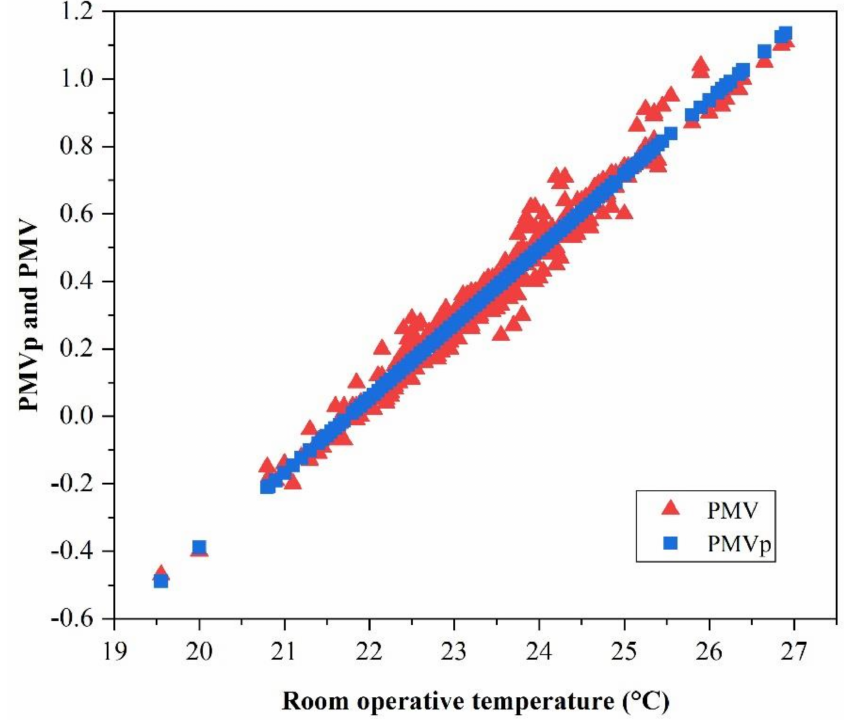
Figure 17. Predicted mean vote for patients (PMVp) and predicted mean vote (PMV) as a function of operative